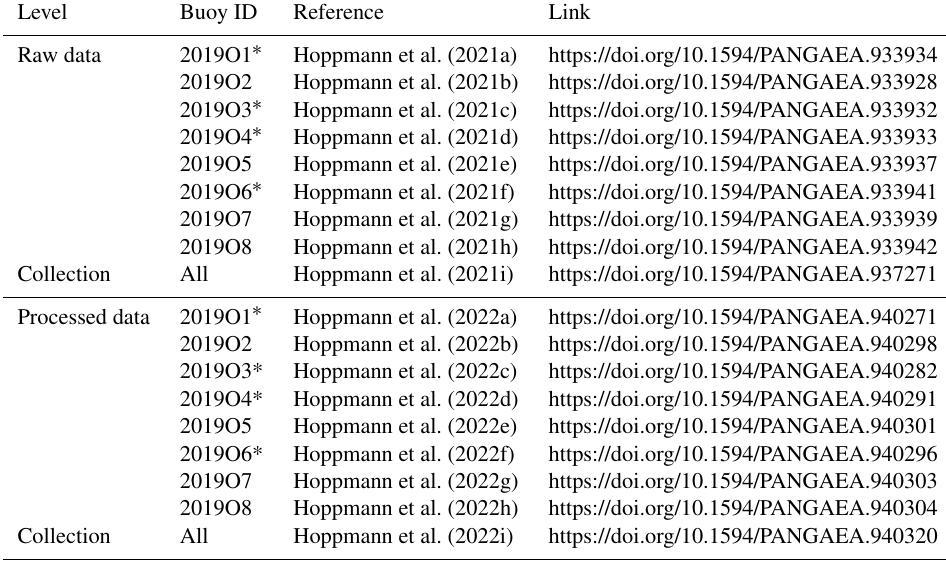
Table 3. Overview of datasets described in this paper. Level Buoy